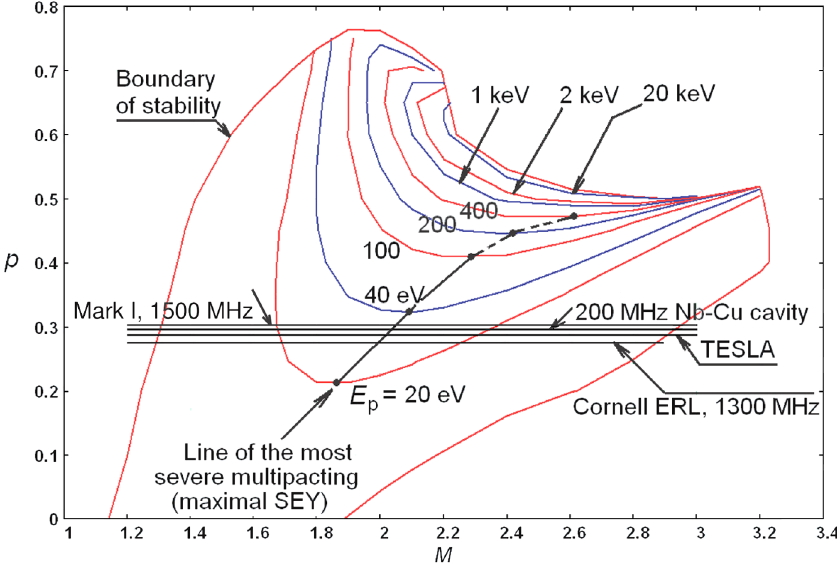
FIG. 8. Equatorial cross-field two-point first-order multipacting zone. Emission energy of the electrons is 2 eV. Examples for several geometries: 1—200 MHz Nb-Cu cavity [8], 2—TESLA cavity [4], 3—Cornell ERL cavity [9], Mark I cavity [10]. E p is the impact